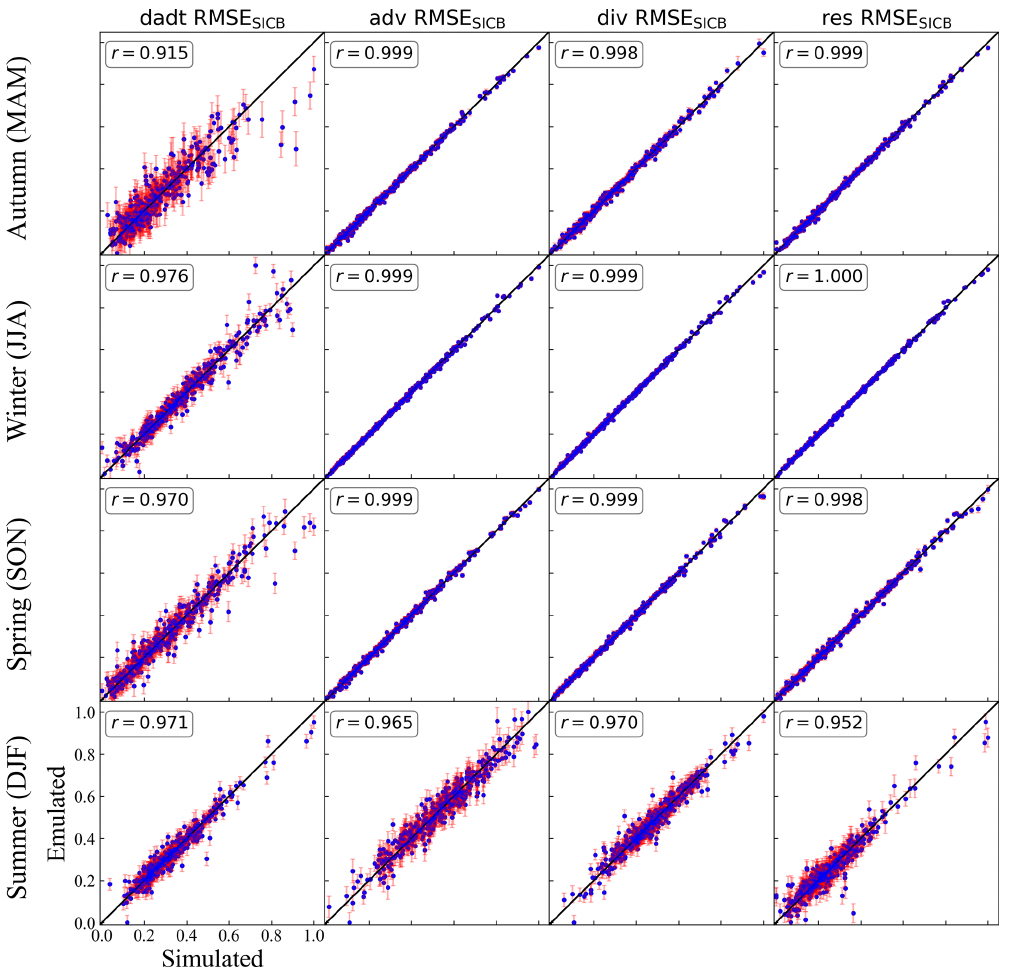
Figure B5. The same as Fig. B4 but for the root-mean-square error between SIC budget components of the simulation and the observation (RMSE SICB